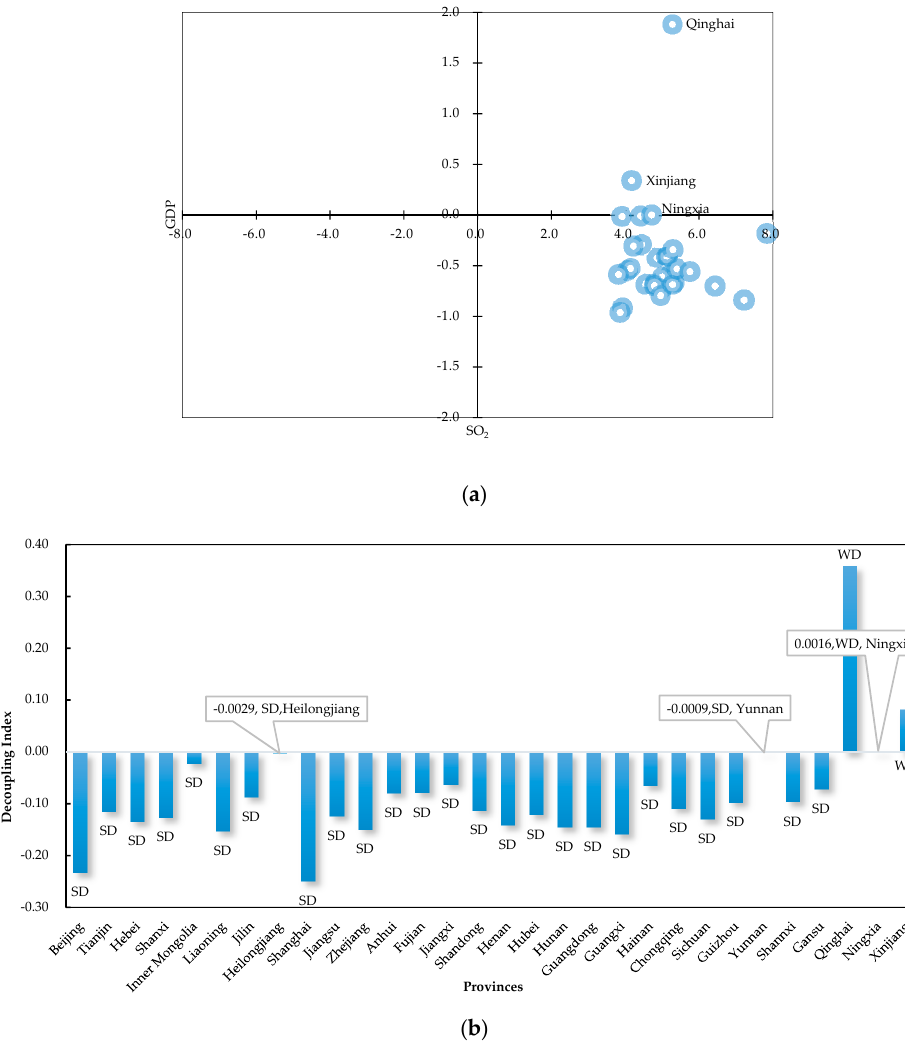
Figure 2a—from the perspective of spatial analysis. In the context of positive economic growth in all provinces, SO 2 emissions increased in only three provinces (Qinghai, Xinjiang, and Ningxia) and fell in all others, so that Qinghai, Xinjiang, and Ningxia failed to achieve SD condition; see Figure 2b.